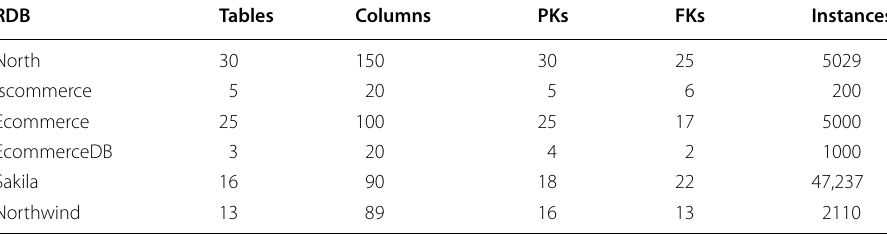
Table 3 A list of metadata extracted from RDB RDB Tables Columns PKs FKs Instances North 30 150 30 25 5029 Iscommerce 5 20 5 6 200 Ecommerce 25 100 25 17 5000 EcommerceDB 3 20 4 2 1000 Sakila 16 90 18 22 47,237 Northwind 13 89 16 13